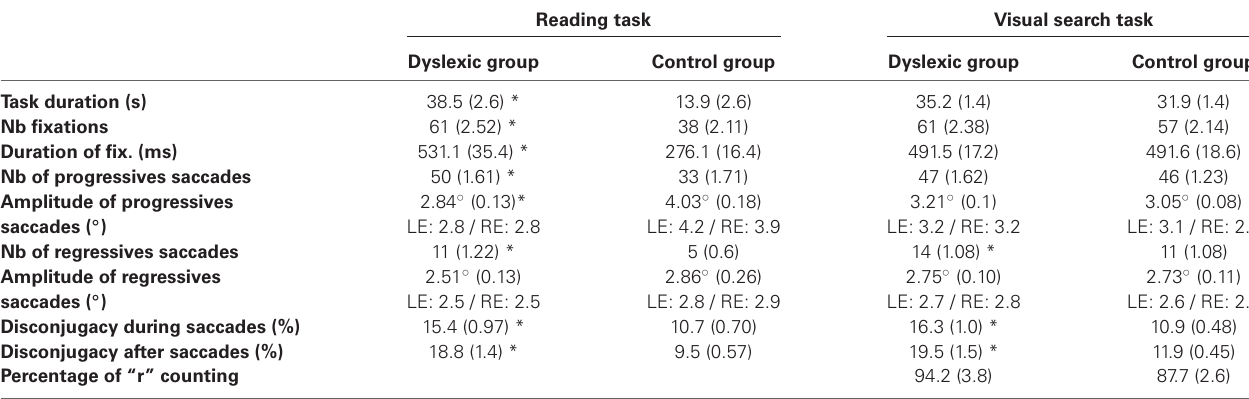
Table 2 | Ocular motor characteristic of the two groups of children examined (dyslexic and control children) during reading and visual search task . Reading task Visual search